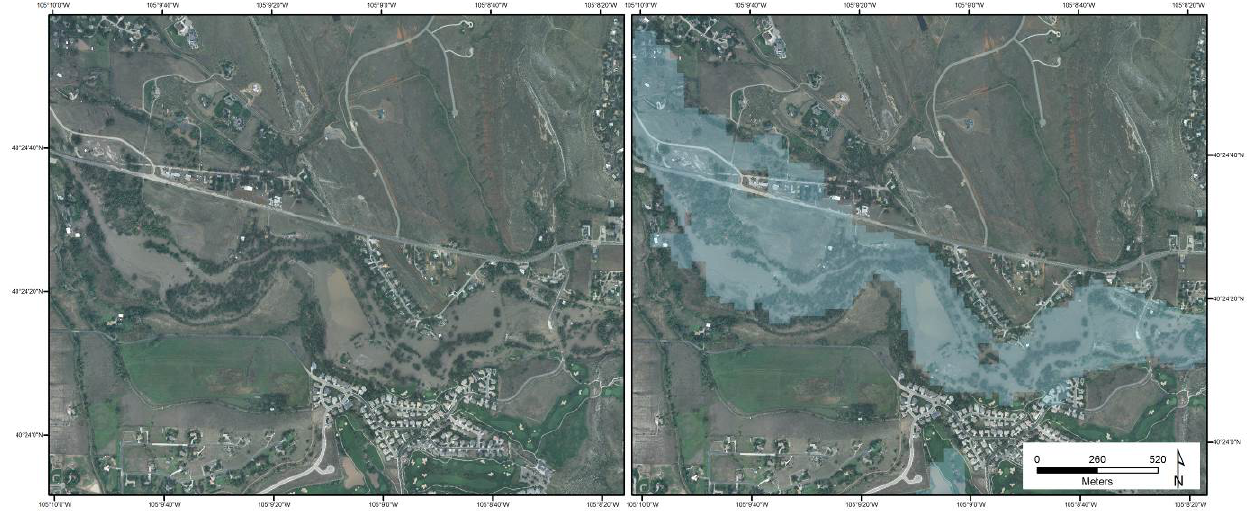
Figure 6. Orthophotograph of a reach of the Big Thompson River in Loveland, Colorado. The left image shows the flooding as of 14 September 2013, and the right shows the same image overlaid with the ICA modeled flood (semi-transparent